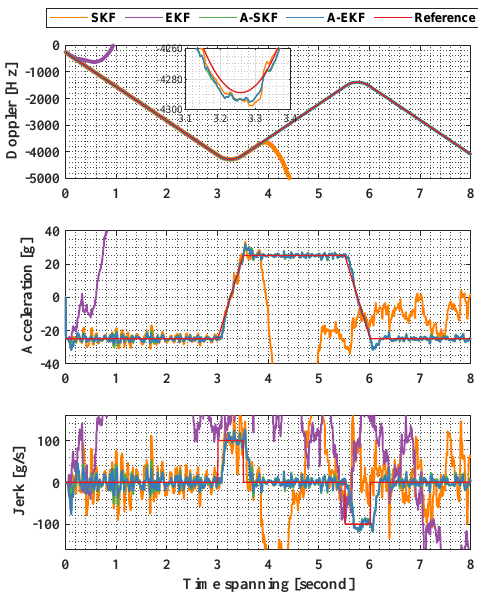
Figure 8. Tracking results when C /N 0 is set to 25